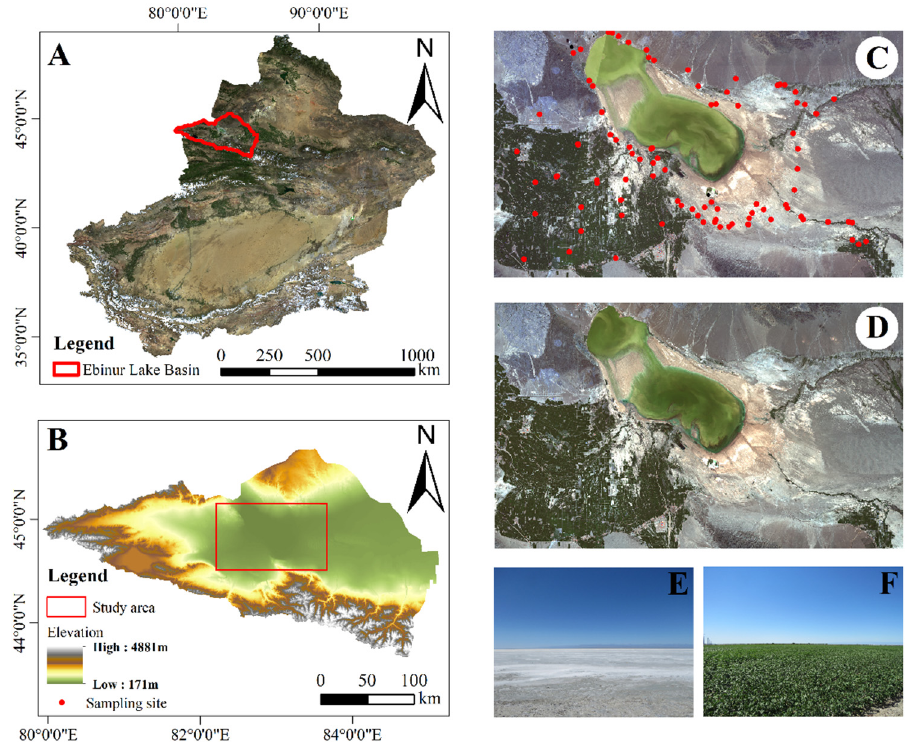
Figure 1. The study area is located in the Xinjiang Uyghur Autonomous Region within China: ( A ) Xinjiang Uyghur Autonomous Region within China; ( B ) The Ebinur Lake basin; ( C ) Sentinel-2A image; ( D ) Landsat 8 image; ( E ) landscape around the Ebinur Lake; ( F ) farmland landscape within the oasis. Images A, C and D were created using the Red, Green and Blue bands of remote sensing